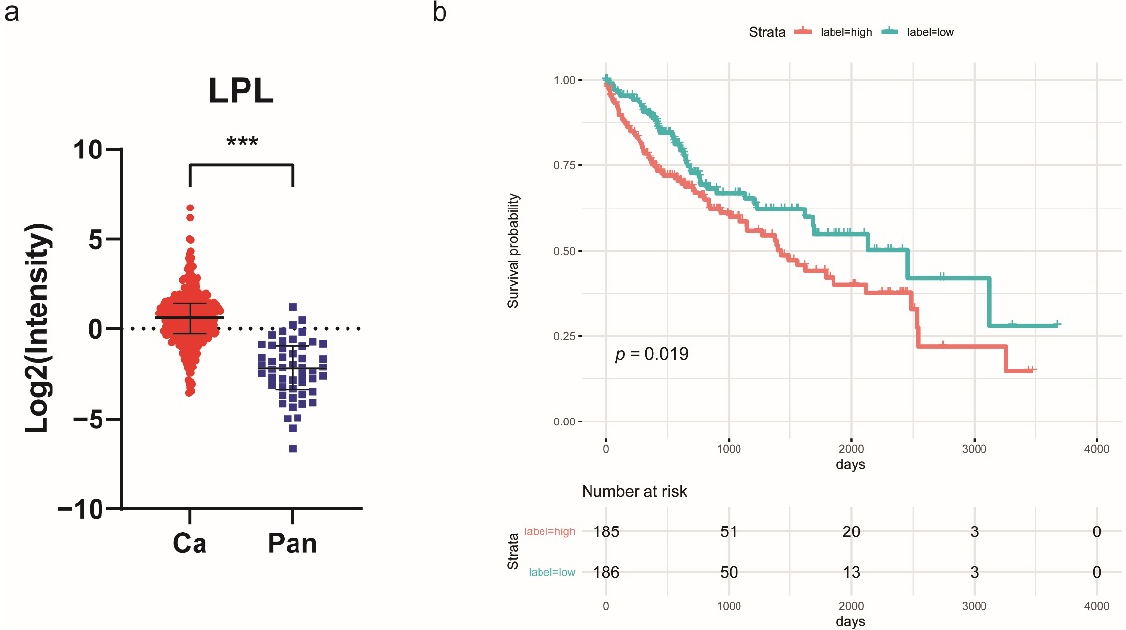
Figure 7. LPL levels are upregulated in HCC tissues and associated with poor prognosis. ( a ) LPL mRNA levels in HCC (red circle) and adjacent normal (blue square) tissues in the TCGA-LIHC dataset. The p -value was assessed using the Mann–Whitney U test (*** p < 0.0001). ( b ) Overall survival analysis was plotted using the TCGA database at the threshold p -value of < 0.05.